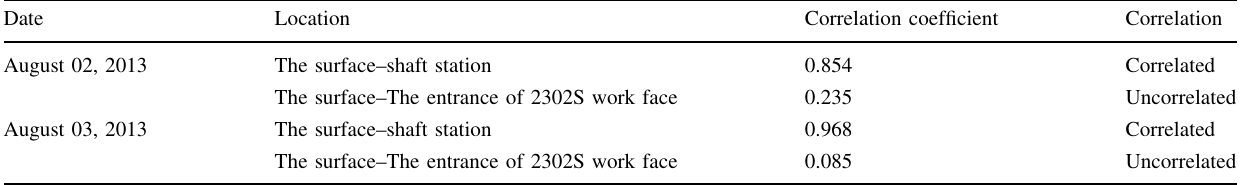
Table 3 Correlations between wellhead and intake air temperatures at the shaft station and working